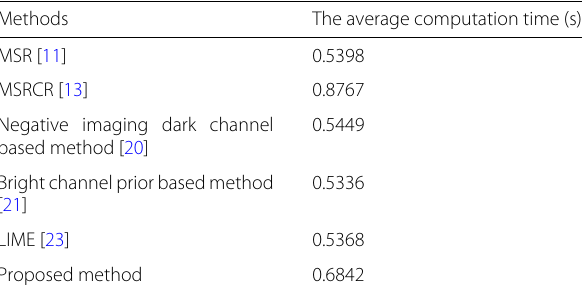
Table 2 Comparison of the average computation time of different methods